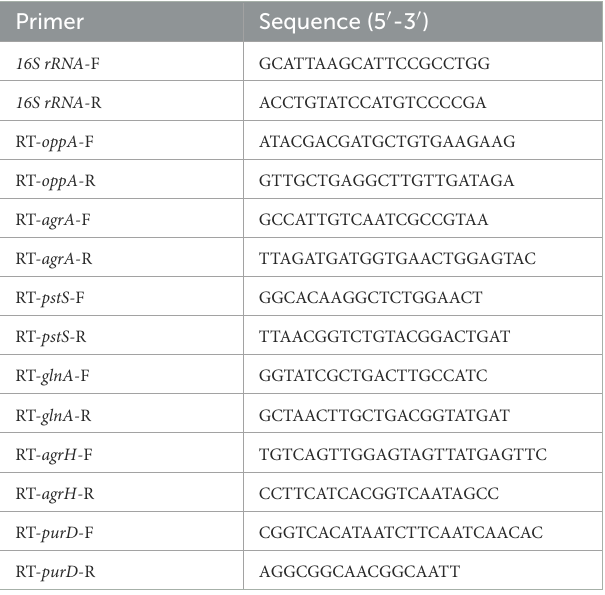
TABLE 2 Primers used for key differential genes